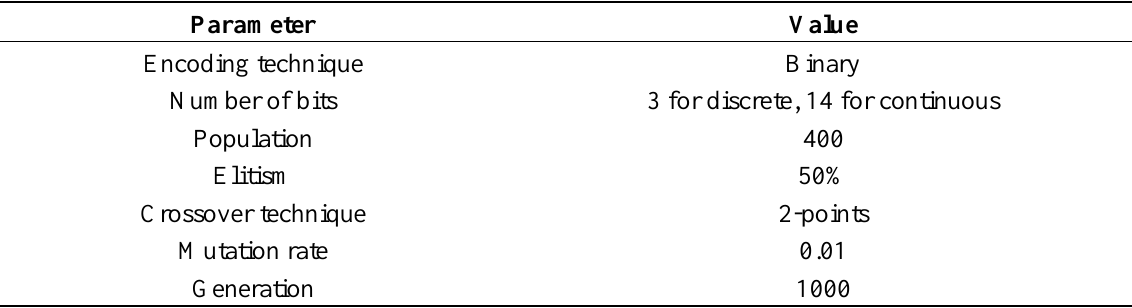
Figure 4. Schematic of the hybrid master-slave genetic algorithm neural network (HGANN) algorithm. Table 2. GA